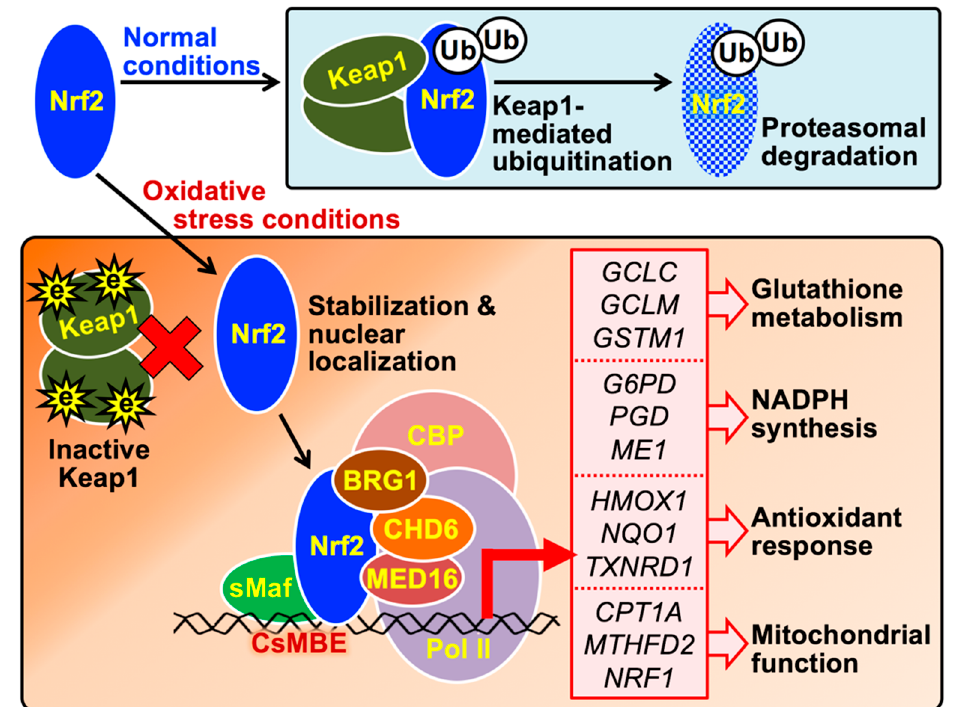
Figure 2. The molecular mechanism by which Nrf2 induces the expression of genes involved in cytoprotection against oxidative stress. In cells free of oxidative stress, the newly synthesized Nrf2 protein is directly captured by the Keap1 homodimer and degraded through the ubiquitin-proteasome pathway. Under oxidative stress conditions, Nrf2 avoids Keap1-mediated degradation because Keap1 is denatured by ROS or electrophiles (e). Stabilized Nrf2 is translocated into the nucleus and forms heterodimers with small Maf (sMaf) proteins, enabling binding to CsMBE in the promoters or enhancers of antioxidant genes (listed in the red box); transcription of these genes is induced by the Nrf2 complex containing CBP, BRG1, CHD6, and MED16. HMOX1 , heme oxygenase 1; NQO1 , NADPH quinone oxidoreductase 1; TXNRD1 , thioredoxin reductase 1; G6PD , glucose-6-phosphate dehydrogenase; PGD , 6-phosphogluconate dehydrogenase; ME1 , malic enzyme 1; GCLC , glutamate cysteine ligase catalytic subunit; GCLM , glutamate cysteine ligase modifier subunit; GSTM1 , glutathione S-transferase µ 1; CPT1A , carnitine palmitoyltransferase 1A; MTHFD2 , methylenetetrahydrofolate dehydrogenase 2; NRF1 , nuclear respiratory factor 1.